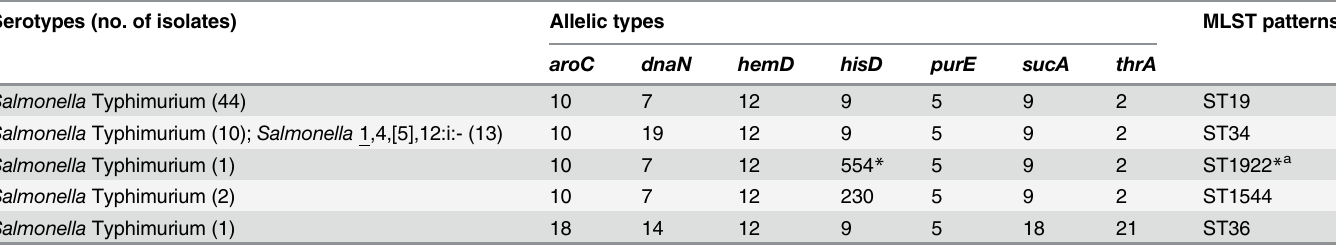
Table 4. Allelic profiles and MLST types of the 71 Salmonella isolates. Serotypes (no. of isolates)